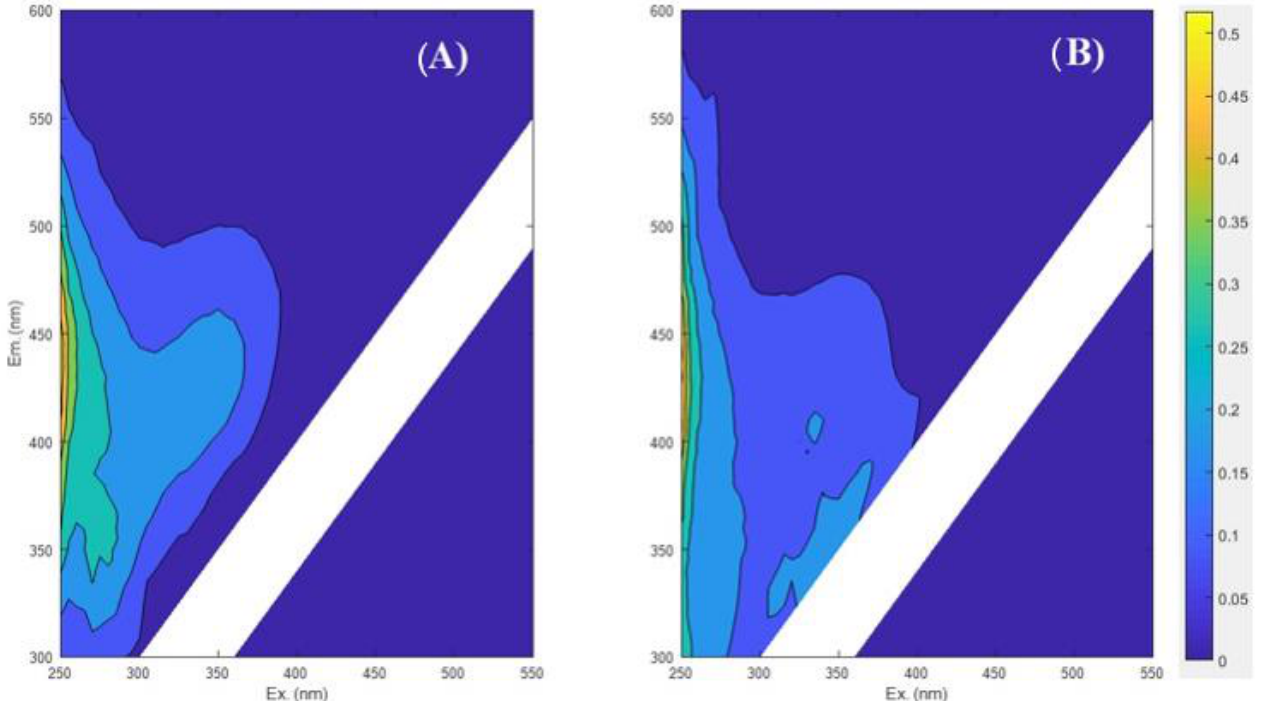
Figure 7. Excitation emission matrices were obtained for WWTP1 ( A ) and c-f-WWTP2 ( B ).